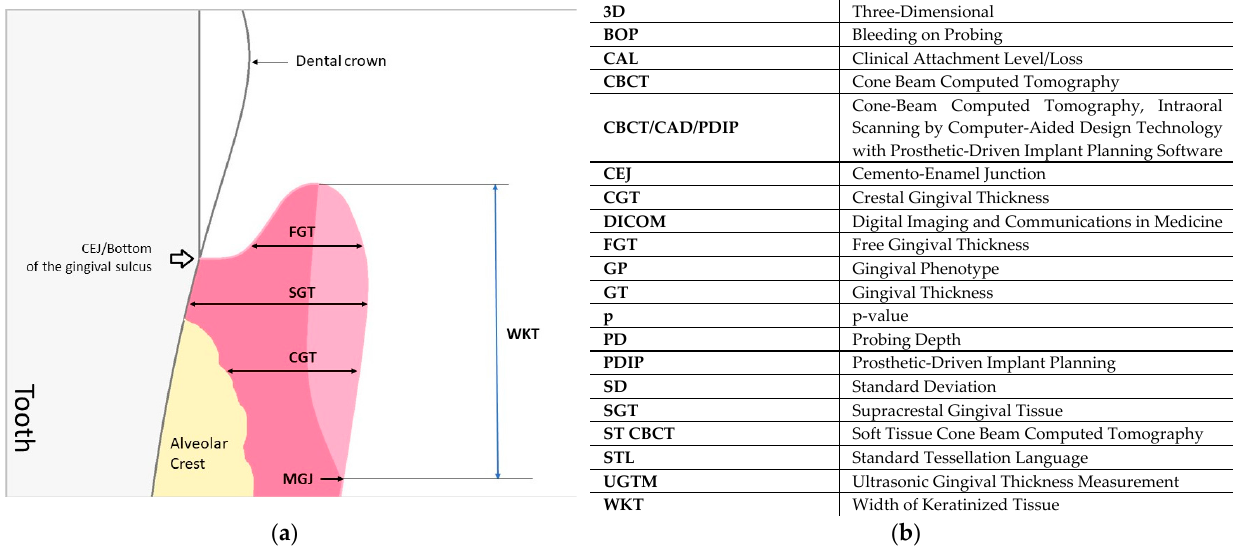
Figure 1. ( a ) Scheme of the periodontal structures and ( b ) abbreviations used in the